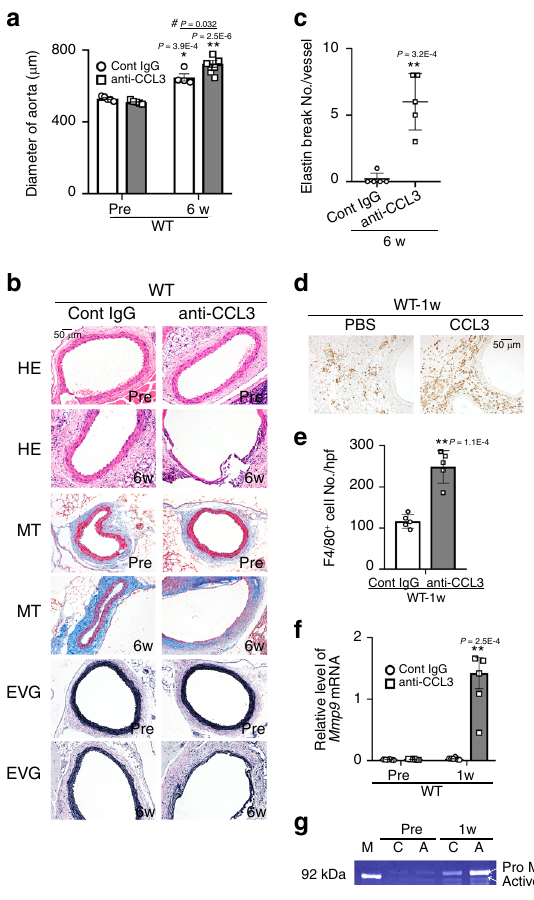
Fig. 3 Effects of the administration of anti-CCL3 Abs on CaCl 2 -induced AAA. a Aortic diameters in mice after CaCl 2 treatment. (Pre: n = 5 each in control IgG and anti-CCL3 treatment; 6 week: n = 4 in control IgG treatment, n = 8 in anti-CCL3 treatment). ** P <0.01, * P <0.05, vs. pretreatment in each strain; # P <0.05, vs. PBS-treated mice. b Histopathological analysis of the aortas obtained from control IgG-treated and anti-CCL3-treated WT mice after CaCl 2 treatment. Representative results from 4 independent experiments are shown here. Scale bar, 50 µ m. c Quanti fi cation of the number of elastin breaks per vessel ( n = 5 each in control IgG and anti-CCL3 treatment). ** P <0.01, vs. control IgG. d Macrophage accumulation into aortic tissues of control IgG-treated and anti-CCL3 treated mice after CaCl 2 treatment. Representative results from fi ve independent experiments are shown. Scale bar, 50 µ m. Scale bar, 50 µ m. e Macrophage numbers were measured ( n = 5 each in control IgG and anti-CCL3 treatment). ** P <0.01 vs. control IgG-treated WT mice. f Intra-aortic Mmp9 expression in IgG-treated and anti-CCL3 treated mice after CaCl 2 treatment ( n = 6 each). ** P <0.01, vs. control IgG-treated WT mice. g Intra-aortic MMP-9 activities in IgG-treated and anti-CCL3 treated mice at 2 weeks after CaCl 2 treatment. Representative gel images from four independent experiments are shown. M molecular weight marker, C control IgG, A anti-CCL3. Unpaired two-sided Student ’ s t test was used in ( a ), ( c ), ( e ), and ( f ). Data are presented as mean values±